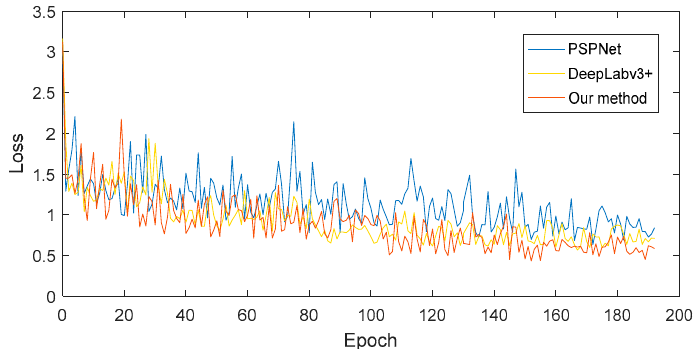
Figure 6. Network model training loss curve.